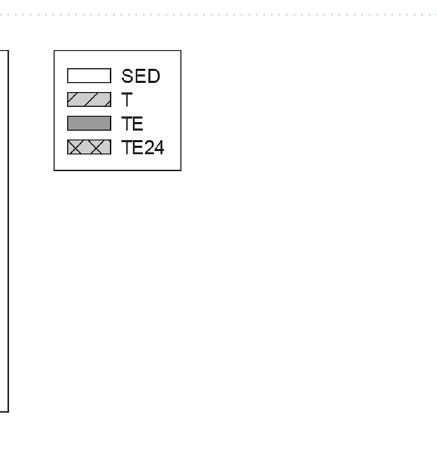
Figure 2. Changes in submaxillary salivary gland IgA and IgM concentration compared to the sedentary group. SED sedentary rats, T trained rats, TE T rats immediately after a final exhaustion test, TE24 TE rats 24 h after the final exhaustion test. Data are expressed as mean ± standard error (n = 8). Statistical differences (one-way ANOVA followed by post-hoc Tukey test): *p < 0.05 vs SED